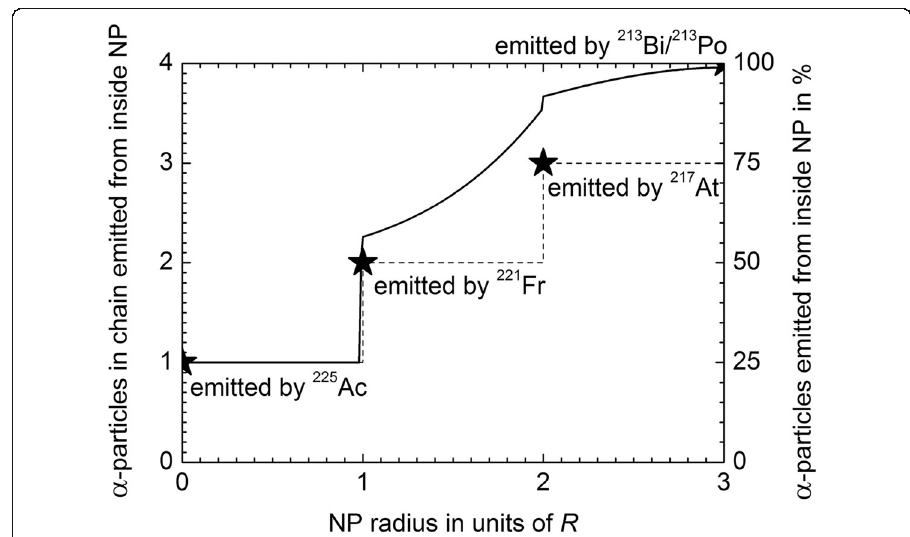
Fig. 7 The left y-axis denotes the number of α -particles in the decay chain of 225 Ac that are emitted from inside a nanoparticle with radius r measured in units of the recoil range R of the decay products of 225 Ac (i.e., of 221 Fr, 217 At and 213 Bi), which is very similar for a given material. It is assumed that the 225 Ac is located in the centre of the nanoparticle at r = 0. The step function refers to the worst case that all recoils are lined up in the same direction. Setting the similar recoil ranges of 221 Fr, 217 At and 213 Bi to R , these daughters of 225 Ac are fully retained in nanoparticles with a radius R , 2 R and 3 R , respectively. The more realistic model considering the sequence of recoils as random steps in arbitrary directions in the three-dimensional space yields a higher recoil retention for nanoparticles larger than R . The right y-axis translates recoil retention into the fraction of α -particles that are emitted from the inside of the